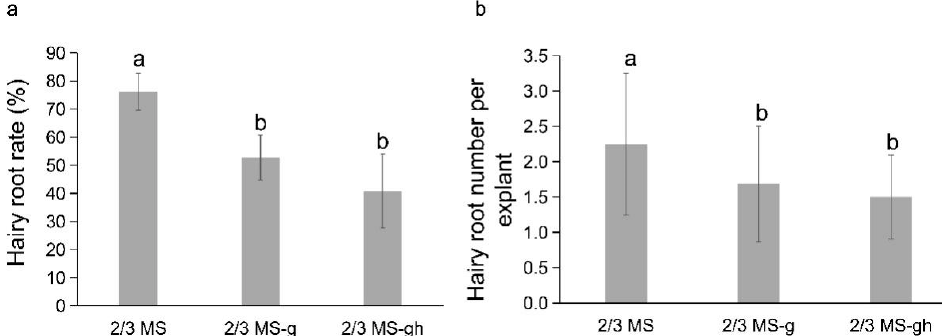
Figure 2. Effects of explant age and R. rhizogenes strain on hairy root generation efficiency. The data were statistically analyzed using one-way ANOVA. The data are presented as the mean ± standard error (SE) ( n = 3). Different letters indicate a statistically significant difference according to Duncan’s multiple range test ( p < 0.05).